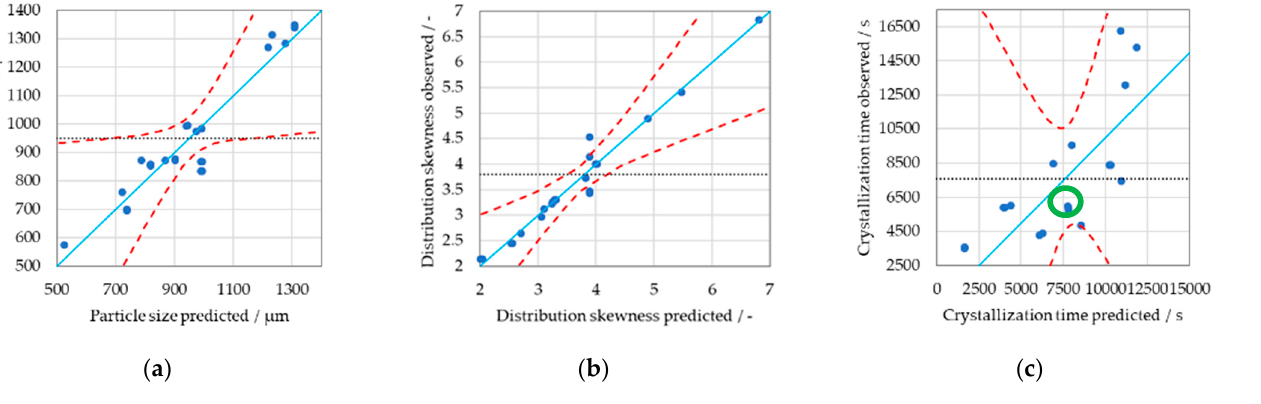
Figure 4. Results of the linear DoE scheme for ( a ) particle size ( 𝑥 (cid:2874)(cid:2871) (cid:4667) , ( b ) skewness of the particle size distribution (k), and ( c ) crystallization endtime. The blue line shows ideal fit, the red dashed lines 95% confidence intervals, and the black dashed line the average.